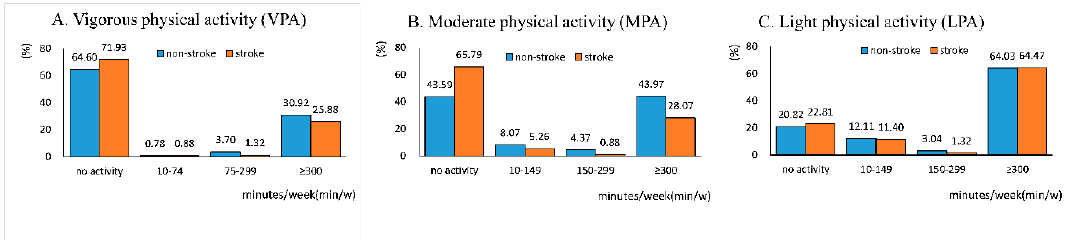
Figure 3. Volume of VPA ( A ), MPA ( B ), LPA ( C ) in participants with and without a stroke. The height of the column represents the proportion of individuals at this level of volume in participants with and without a stroke, respectively. Corresponding proportion is shown above the column.